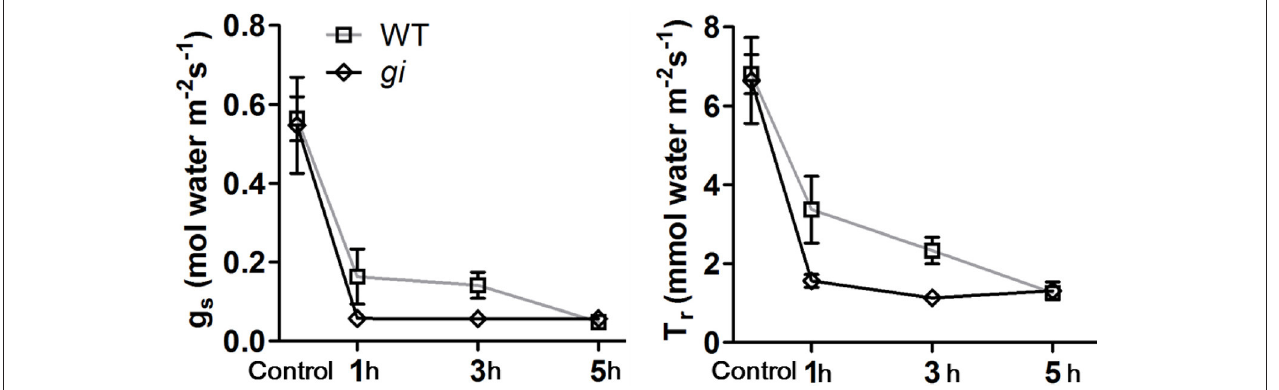
FIGURE 6 | Analysis of stomata conductance (gs) and transpiration rate (Tr) in WT and osgi plants. Stomata conductance (gs) and transpiration rate (Tr) in WT and osgi plants after PEG treatment for 1, 3, and 5h. 35-day-old WT and osgi plants grown under normal conditions or treated with 18% PEG 8000 at 4, 6, and 8h after lights-on, respectively, were used for the experiment. The g s and T r were recorded in osgi and WT plants using an Li-6400 at 9 h after lights-on. All data represent the mean of three biological replicates, with error bars indicating SD.